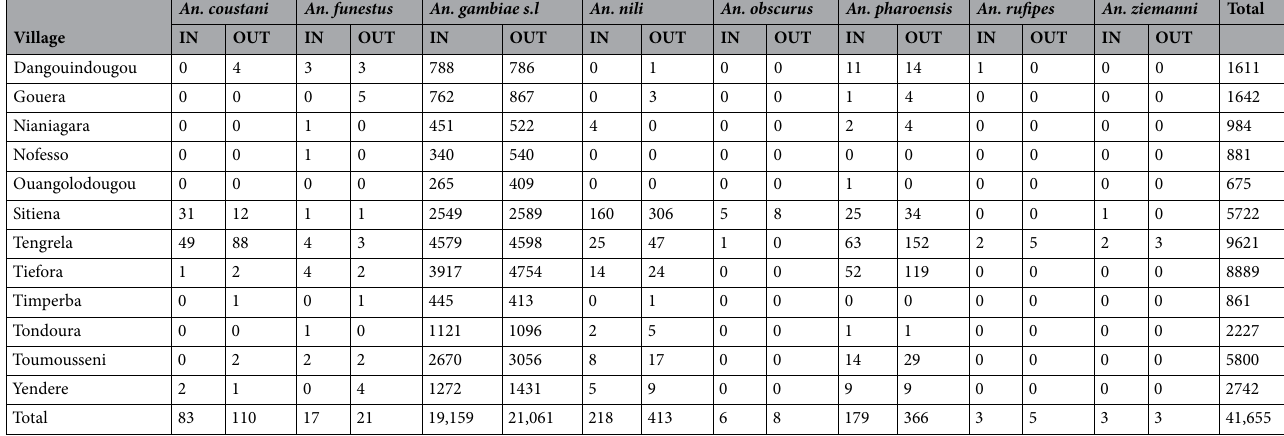
Table 1. Total number of female Anophelines caught using Human Landing Catches in 12 villages of southwestern Burkina Faso, from October 2016 to December 2018. Results are displayed by trapping location (IN = indoor and OUT = outdoor) and village.